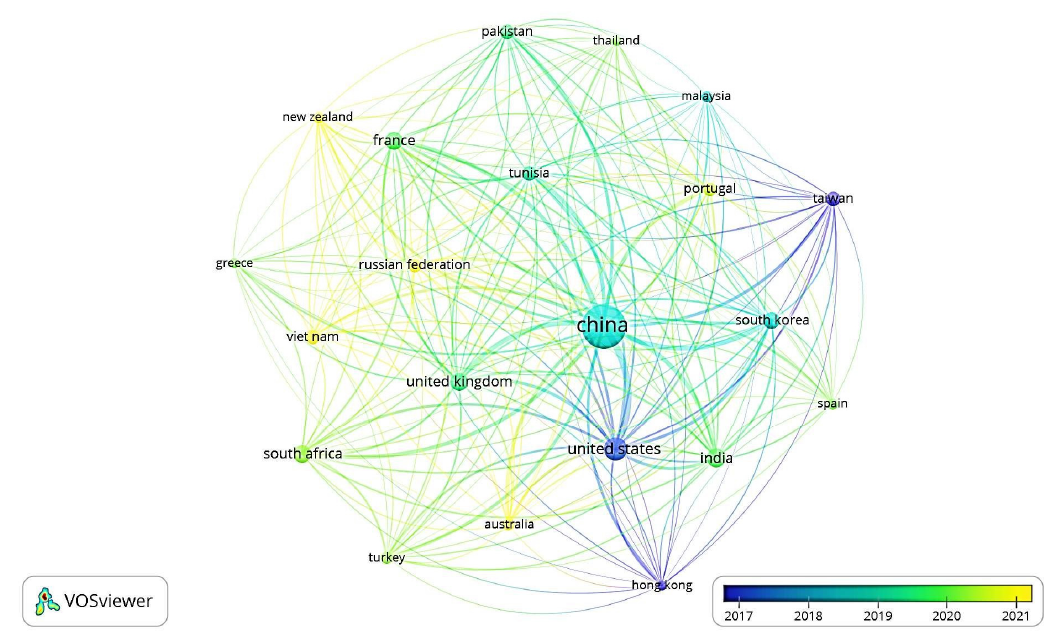
Figure 2. Countries/territories–year-wise publications.